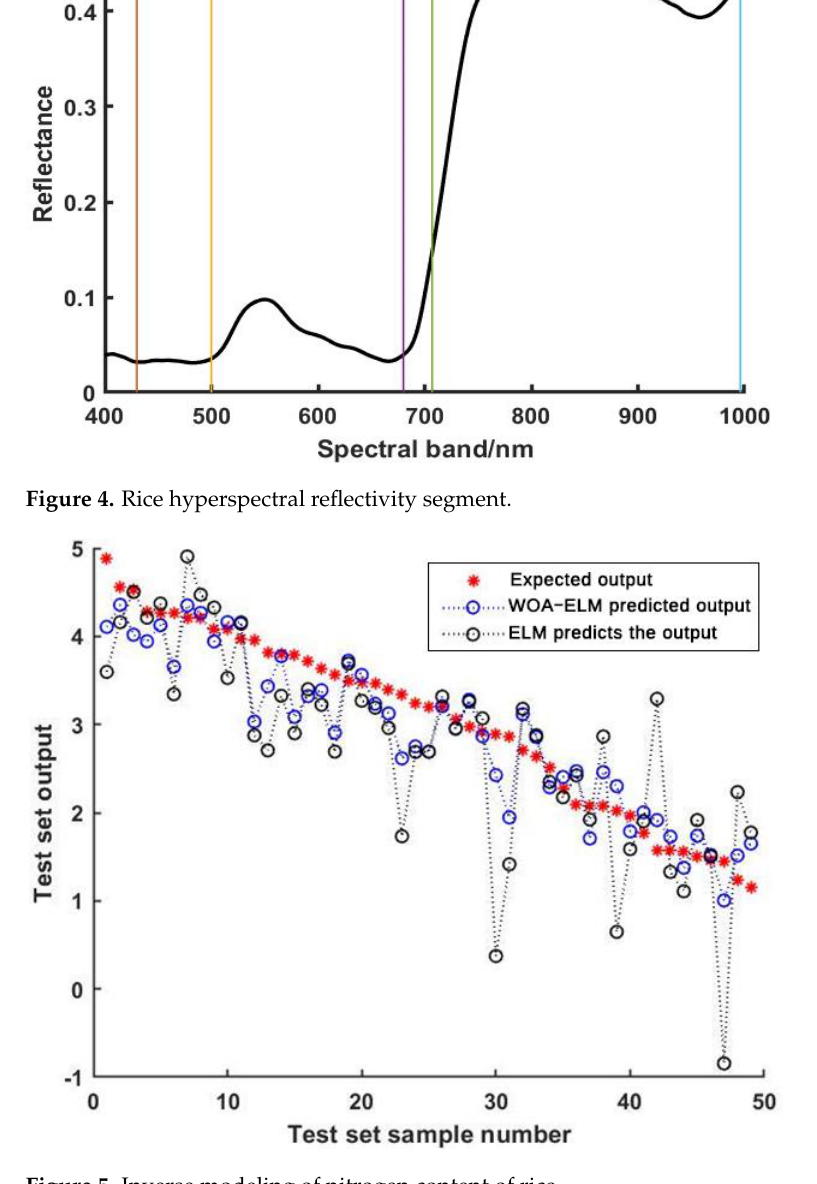
Figure 6. Fertilizer prescription chart for agricultural drones.